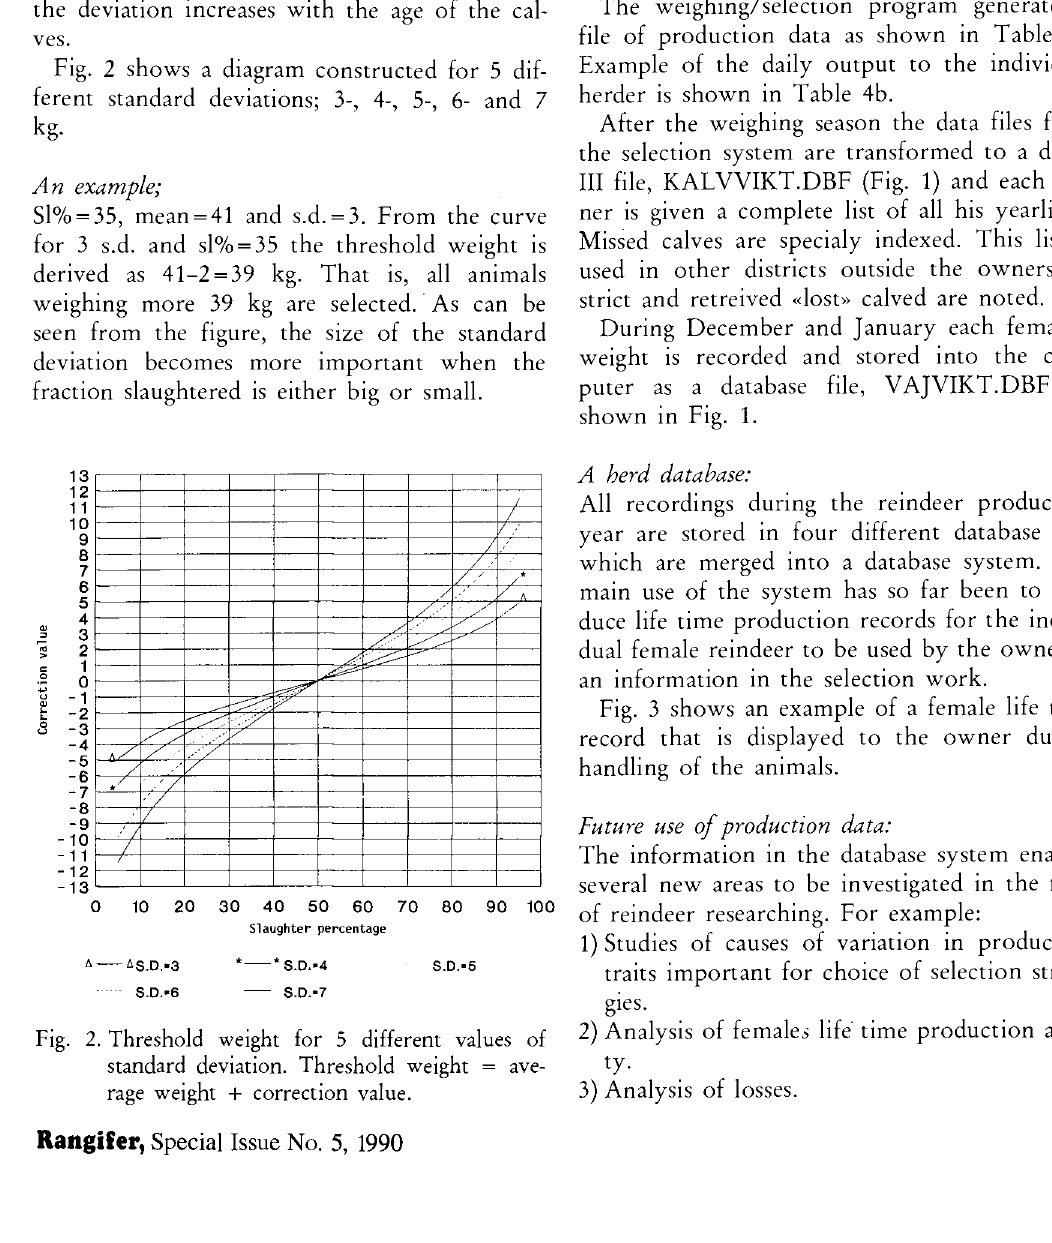
Fig. 2. Threshold weight for 5 different values of standard deviation. Threshold weight = ave rage weight + correction